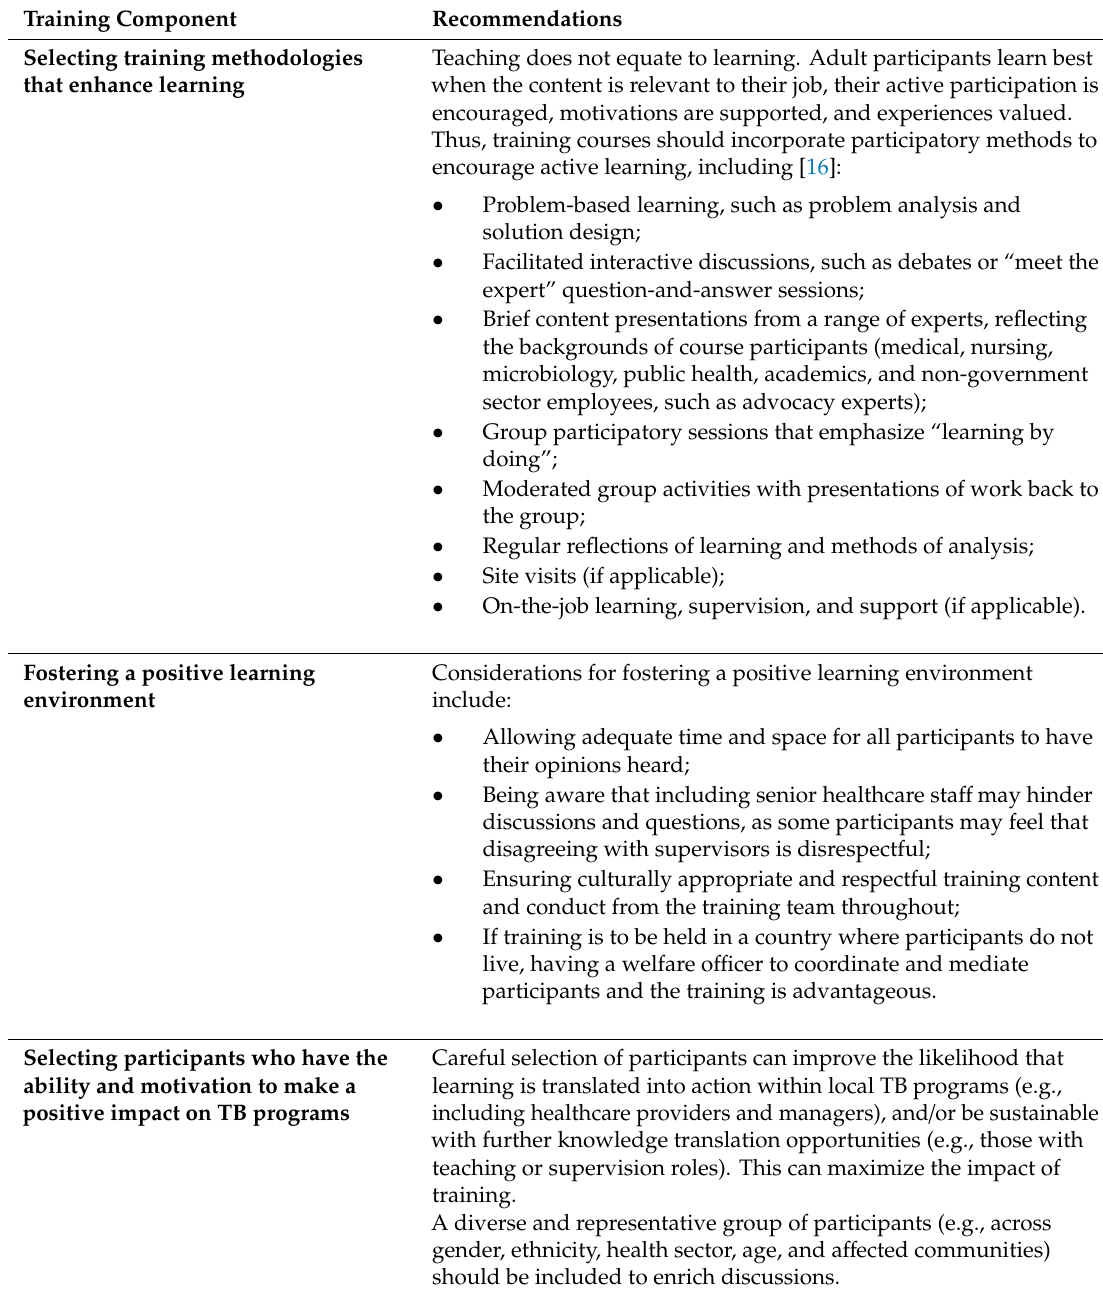
Table 2. Key training components and suggested recommendations for designing and delivering successful